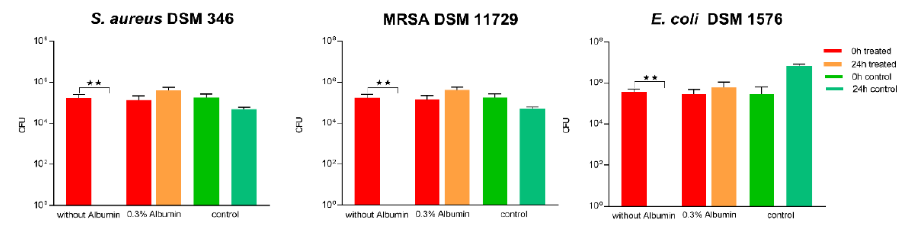
Figure 7. Quantification of viable bacteria using ISO 22196 with high soil load with 0.3% bovine albumin. The results of two independent experiments are shown. A volume of 100 µL of bacterial inoculum was incubated at 99% humidity and 37 °C for 24 h on the 2.5% Cu(NO 3 ) 2 -containing sol–gel surface, as well as a sol–gel surface without additive (control). The initial number of bacteria was quantified immediately after inoculation (0 h treated, red; and 0 h control, green) and after 24 h of incubation (24 h treated, orange; and 24 h control, turquoise). Mean numbers of bacteria per surface (CFU) are displayed on a logarithmic scale with error bars indicating the standard deviation of the respective means. Statistically significant differences between the number of viable bacteria after 24 h of incubation are marked. (Mean with 95% CI, Mann–Whitney-U test; ** corresponds to p ≤ 0.004.)